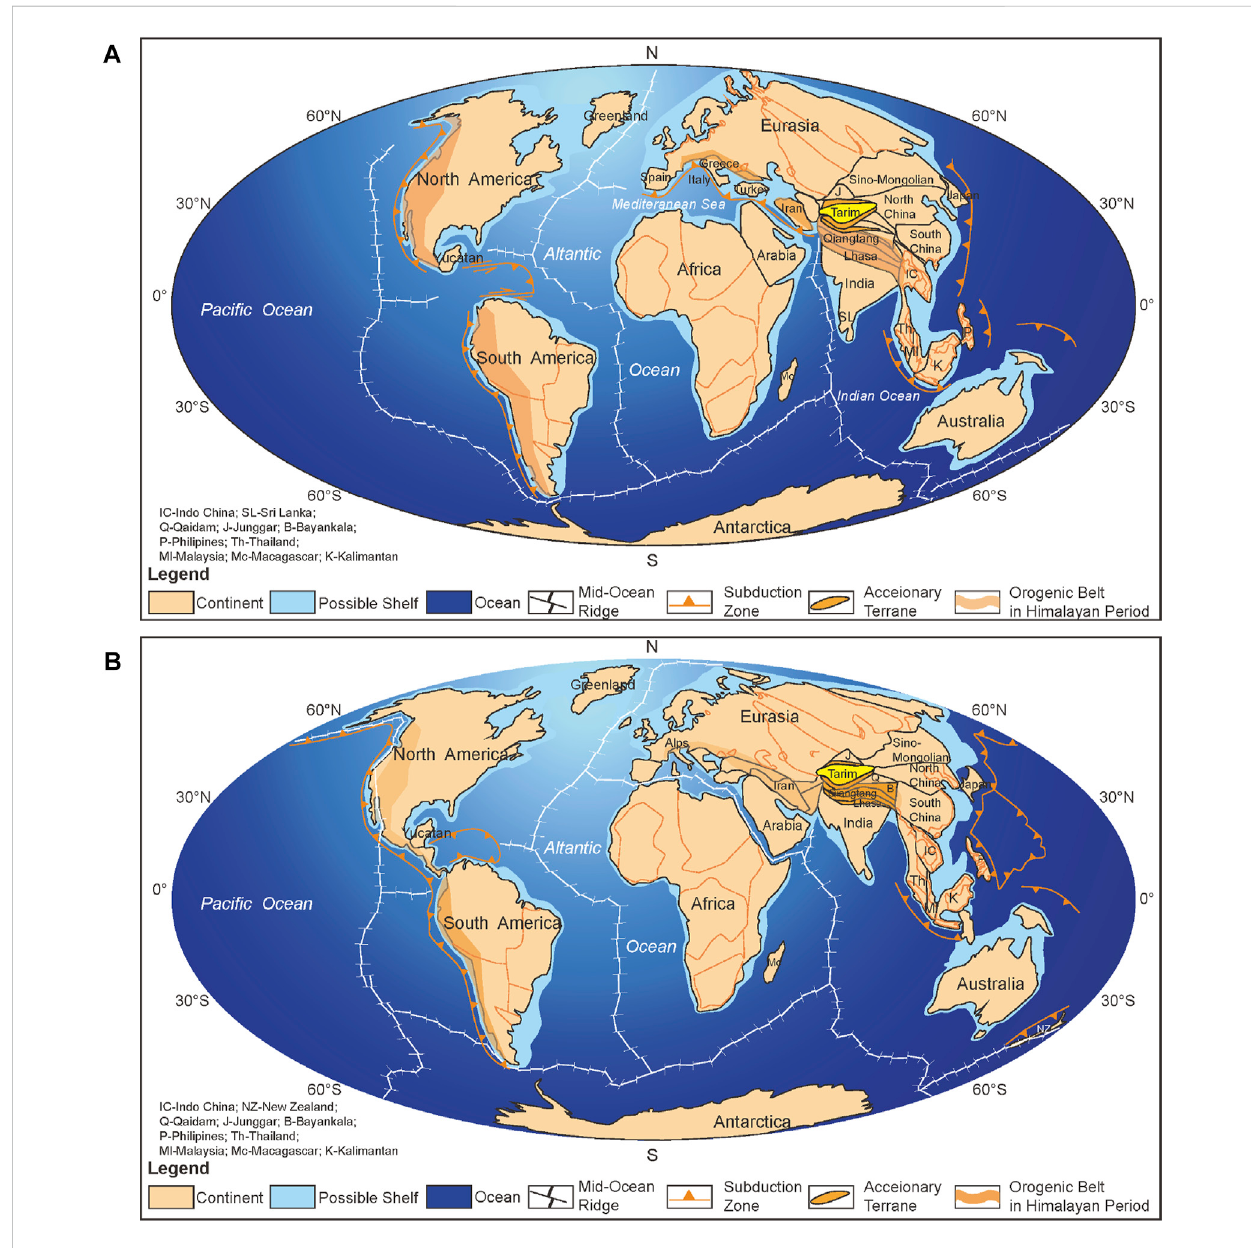
FIGURE 12 Global plate reconstruction in the late Paleogene (A) and Late Neogene (B) (modi fi ed after Scotese, 2004).